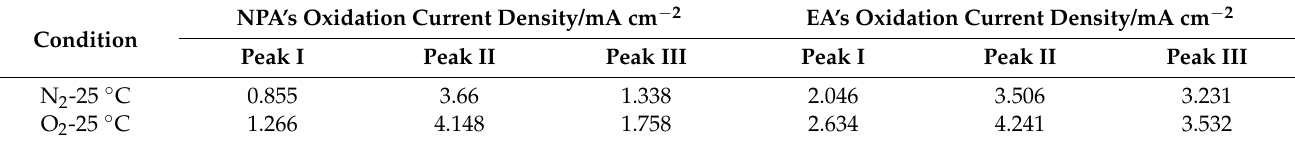
Table 3. Current densities of oxidation peaks recorded from the CV of NPA and